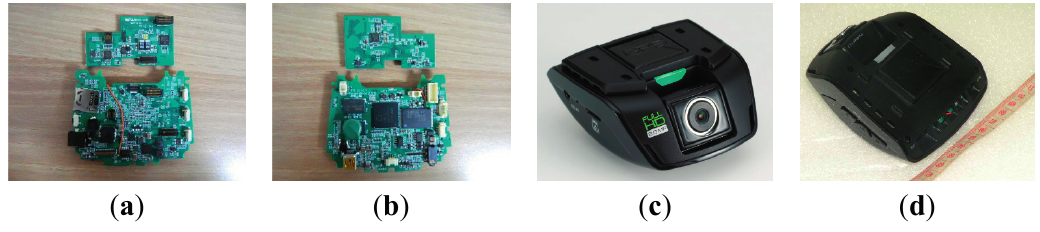
Figure 11. Black-box camera: ( a ) inside top view; ( b ) inside bottom view; ( c ) front view; ( d ) bottom